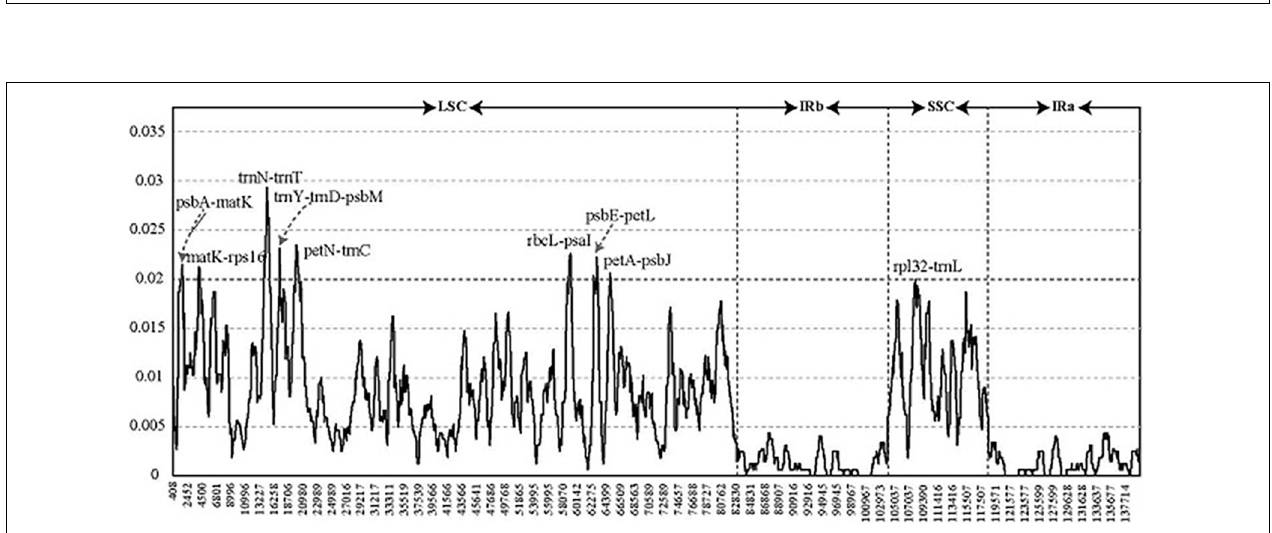
FIGURE 4 | Comparative analysis of the nucleotide diversity values among four Pennisetum chloroplast genomes. X -axis: the position of the midpoint of a window (kb). Y -axis: nucleotide diversity of each window.